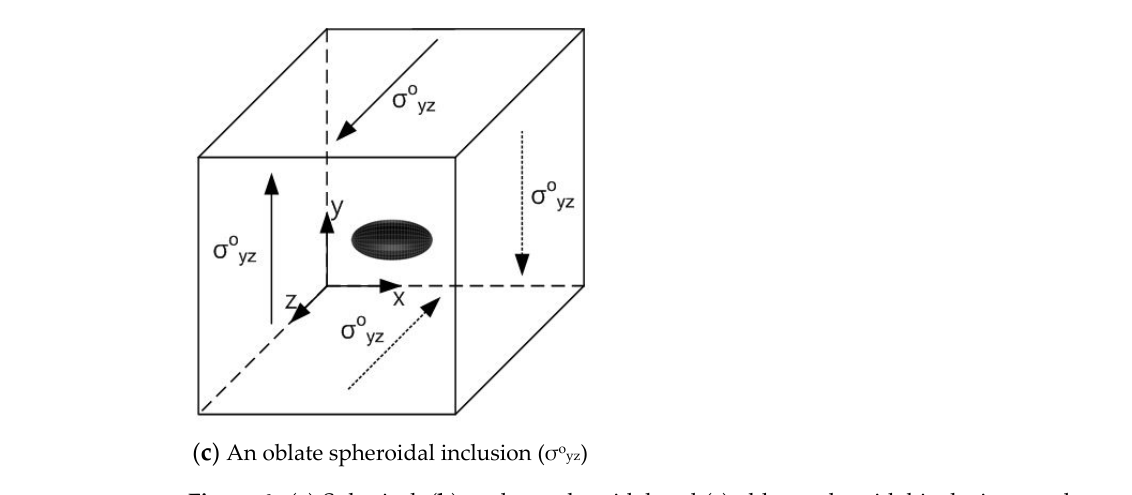
Figure 6. ( a ) Spherical, ( b ) prolate spheroidal and ( c ) oblate spheroidal inclusions under remote shear loading. Table 4. Material properties of the isotropic matrix and the orthotropic inclusions. Table 5. Material Property